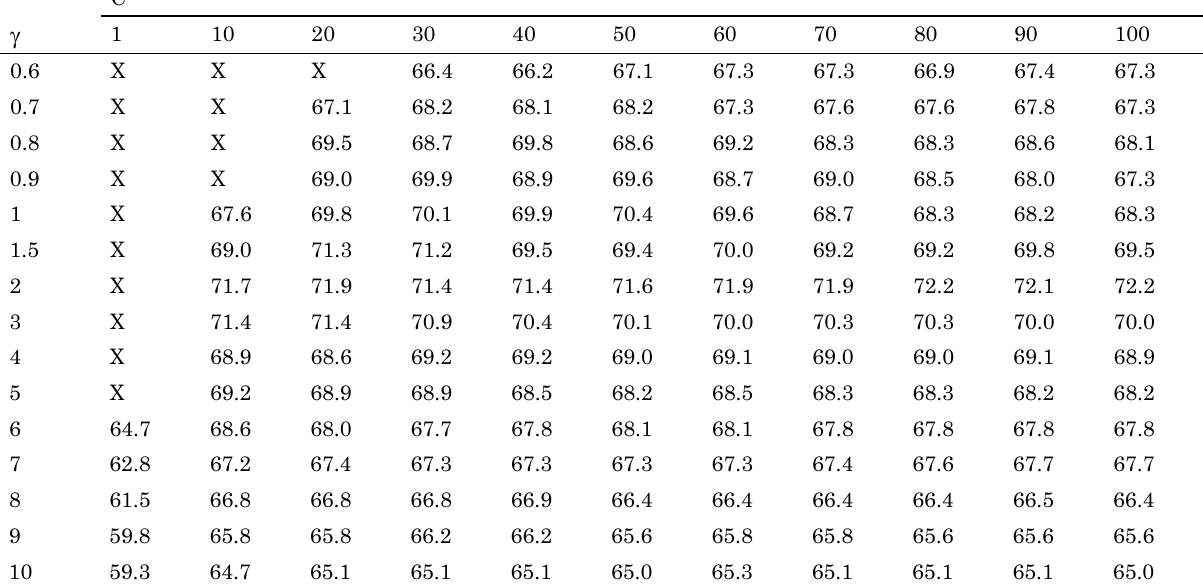
Table 2. Hit-rate of SVM prediction within 20% deviation